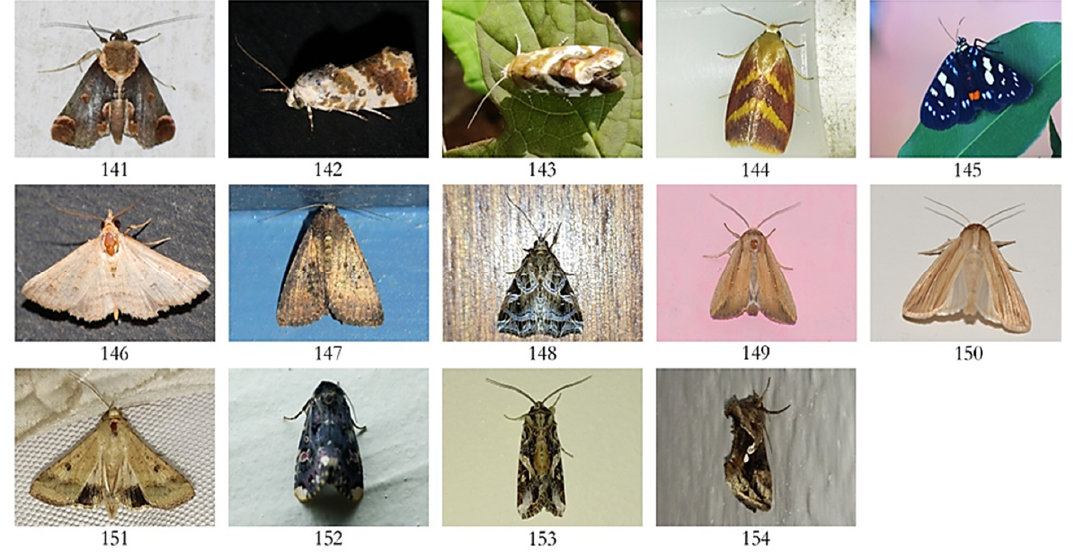
Here in this study, we have recorded 19 moth families being reported from the state of Odisha which includes 154 species under 129 genera. Out of these, 34 moths have been identified only up to the genus level, while the rest have been identified up to species level as indicated in Table 2. In the study, family Crambidae dominated in species diversity, composing 31.2% of the total species (48 species, 38 genera), followed by Erebidae composing 27.3% (42 species, 37 genera), Geometridae making up for 9.7% (15 species, 12 genera) and Noctuidae at 8.4% (13 species, 11 genera). The other families found in less numbers were in the following order of species diversity namely, Sphingidae with seven species in six genera (4.5%), Pyralidae with seven species in five genera (4.5%) and Nolidae with six species in five genera (3.9%). Further, the families Limacodidae, Tortricidae and Uraniidae were represented by two species in two genera each while, Eupterotidae had one genus with two species and the rest eight families (Tineidae, Scythrididae Lasiocampidae, Attevidae, Thyrididae, Bombycidae, Hyblaeidae and Lecithoceridae) were found with a single species in each (Figure